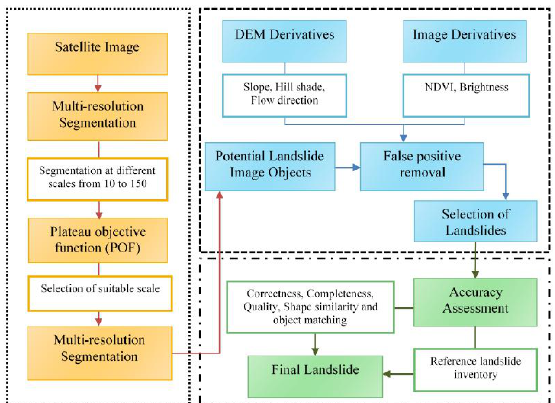
Figure 2. Flow chart showing steps of methods used in the